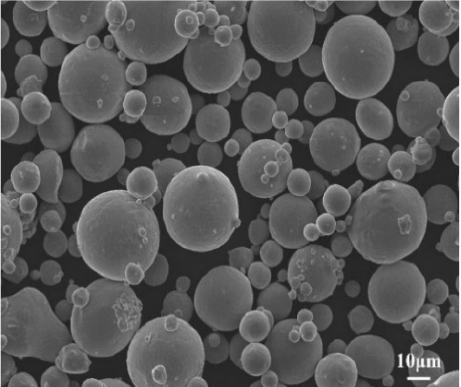
Figure 1. Surface morphology of the Ti–6Al–4V alloy spherical powder particles.